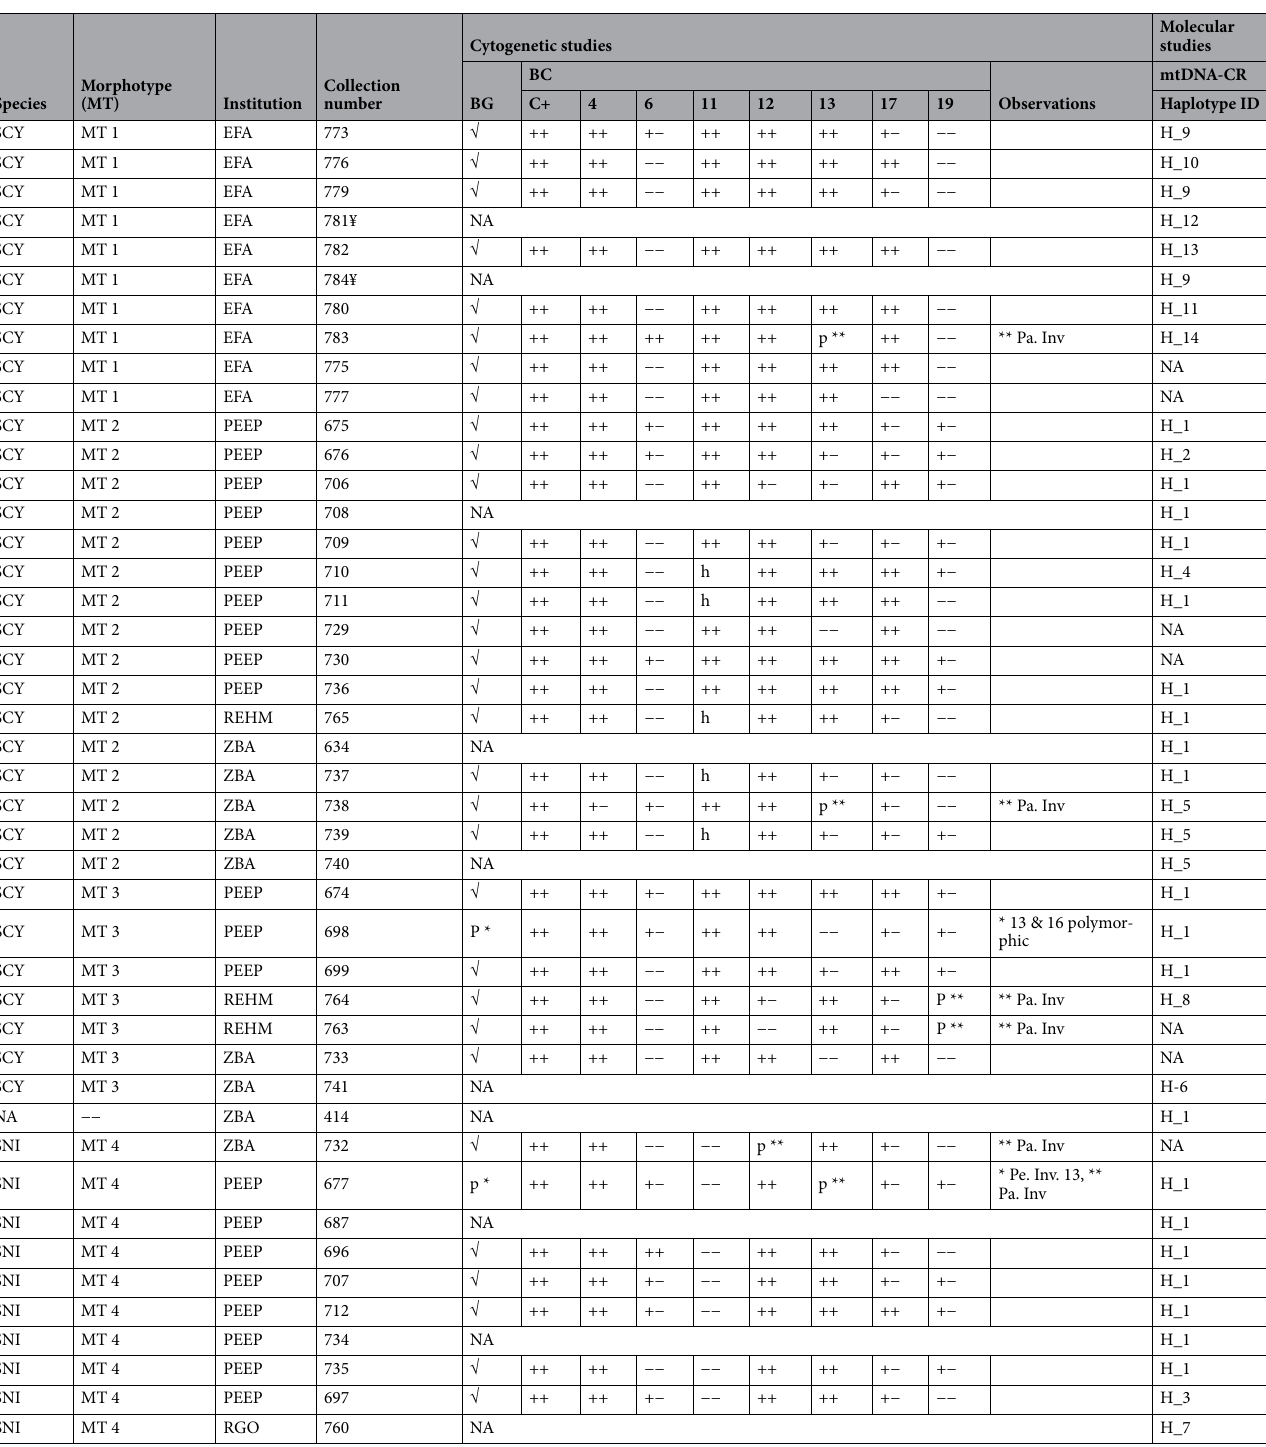
Table 2. Summary of morphological, karyological and molecular data obtained in the present study. √, normal G-pattern; p, polymorphism; + −, presence/absence; h, size heteromorphism; NA, not available. Pe. Inv, pericentric inversion; Pa. Inv, paracentric inversion. Chromosomal data from Nieves et al., 2017. ¥ New analyzed